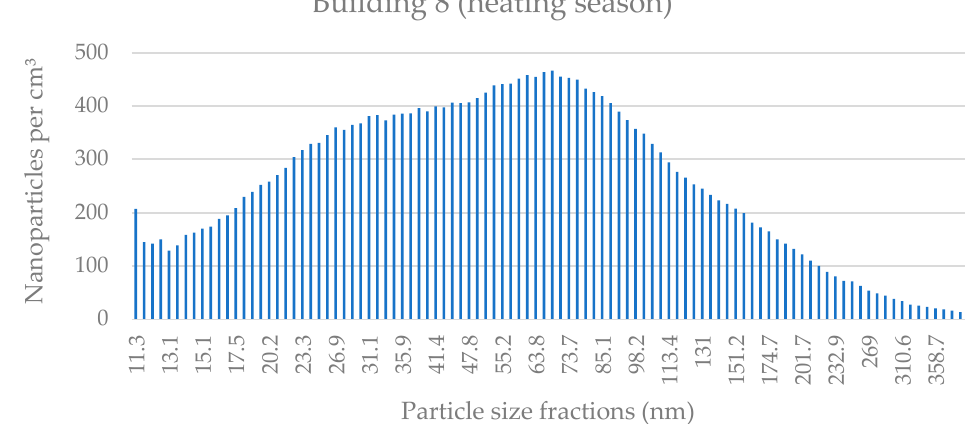
Figure A14. The average nanoparticle concentration in each size fraction in Building 7 during a one-week measurement period during the nonheating season.